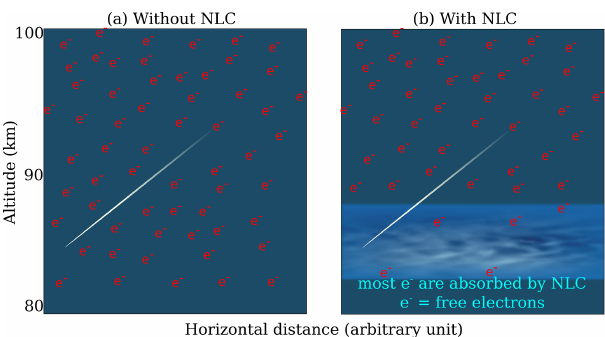
Figure 6. A schematic illustration for the background state without NLC (a) and with NLC (b) is shown. In the with-NLC case back- ground electrons at lower altitudes are mostly taken up by the NLC particles creating a deficiency of electrons, which therefore cannot take part in short-circuiting the trail electrons, and thus the meteor radar-measured diffusion appears to be